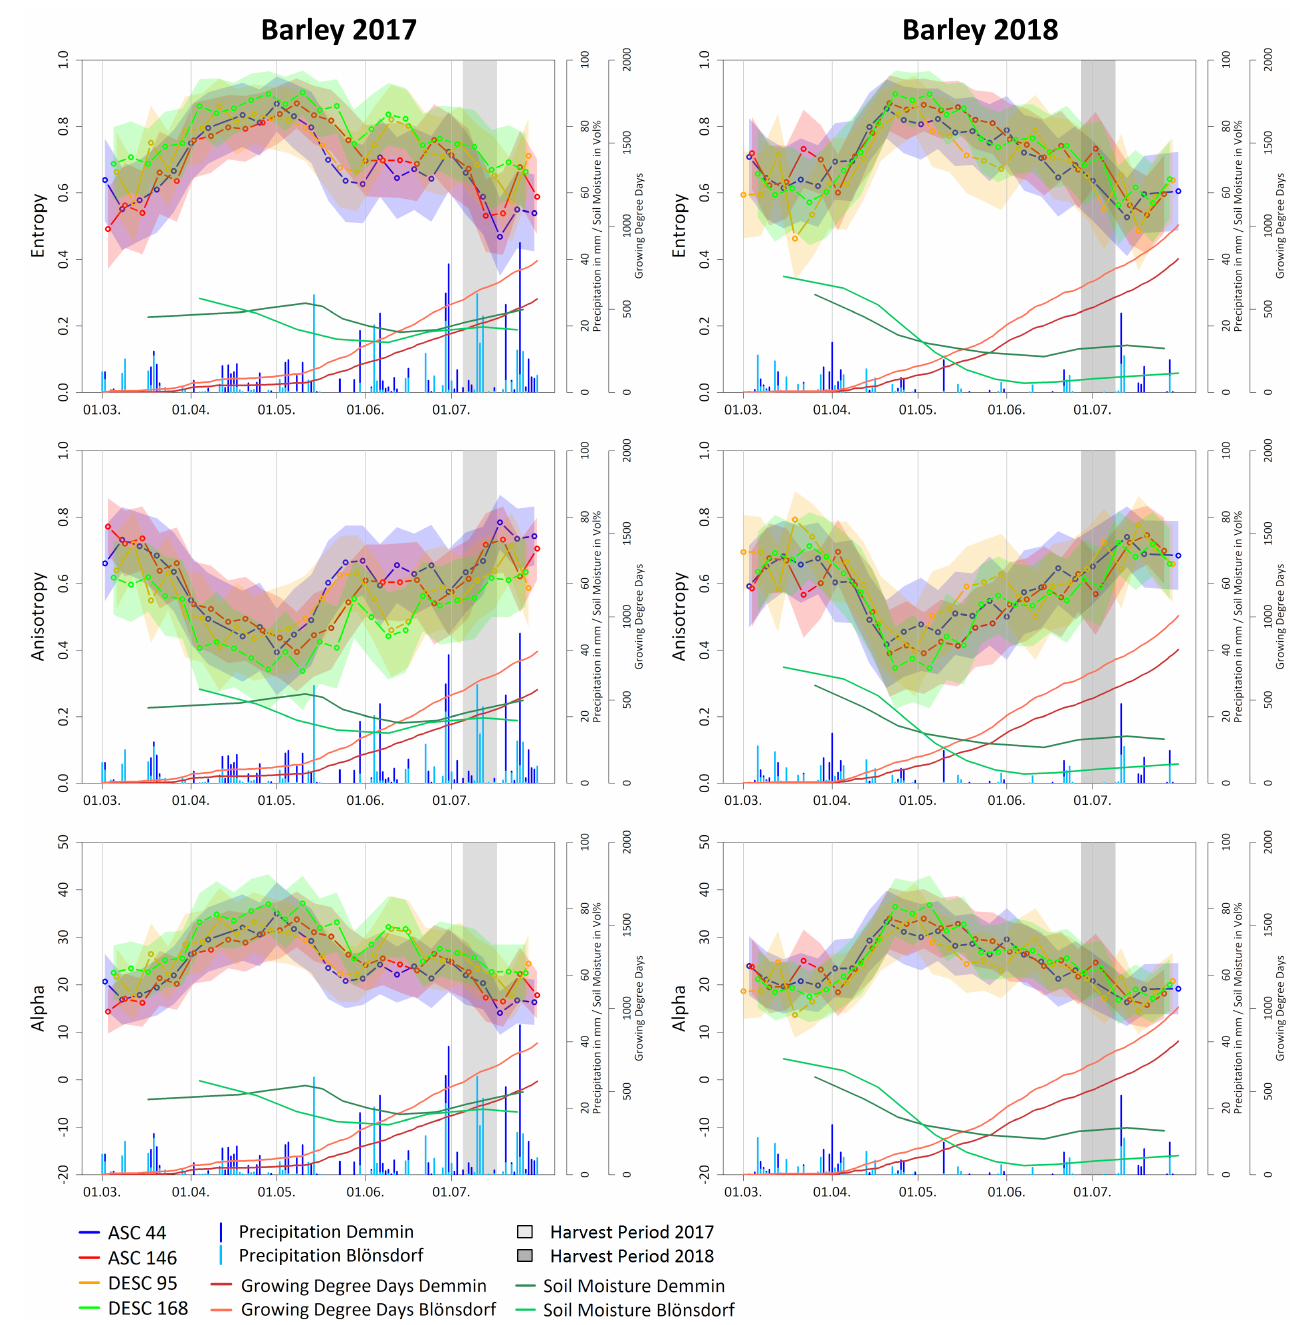
Figure 7. Temporal development of decomposition parameters entropy, anisotropy, and alpha for all barley fields in 2017 ( left ) and 2018 ( right ): polygons around the lines indicate ± one standard deviation. Blue bars represent the daily precipitation sums, red lines show the cumulative growing degree days, and green lines represent soil moisture at both test